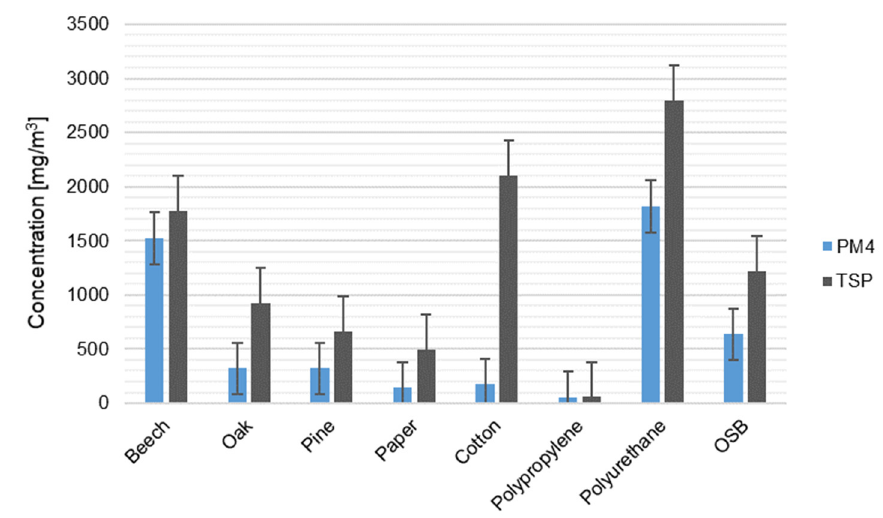
Figure 2. Concentrations (mg/m 3 ) of respirable fraction of particulate matter (PM 4 ) and total suspended particles (TSPs) during a 10-minute combustion of various types of materials ( r = 0.757, p = 0.03).